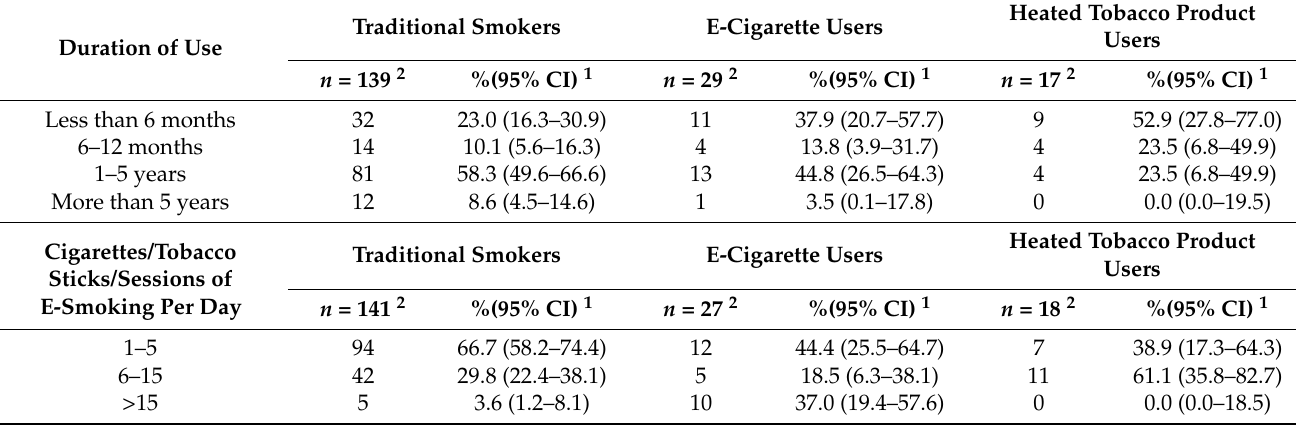
Table 2. Pattern of smoking among exclusive nicotine containing product